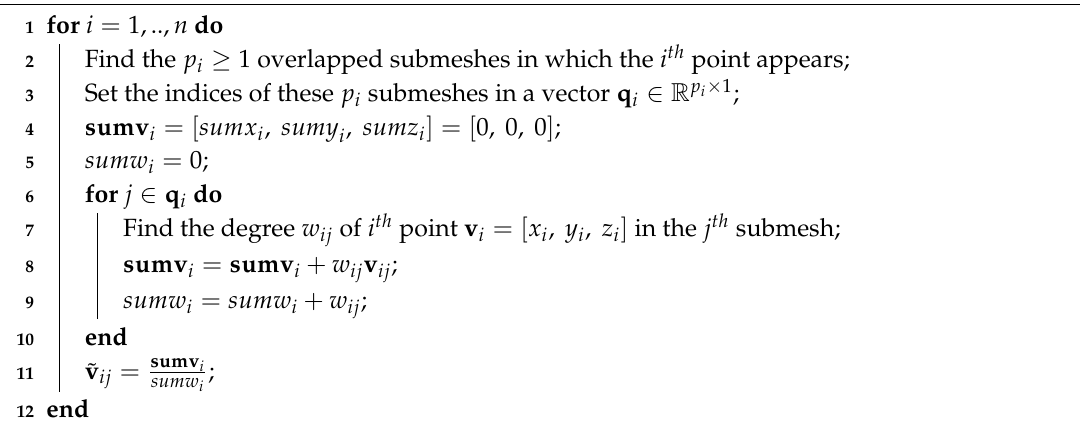
Algorithm 3: Weighted average process for the reconstruction of a